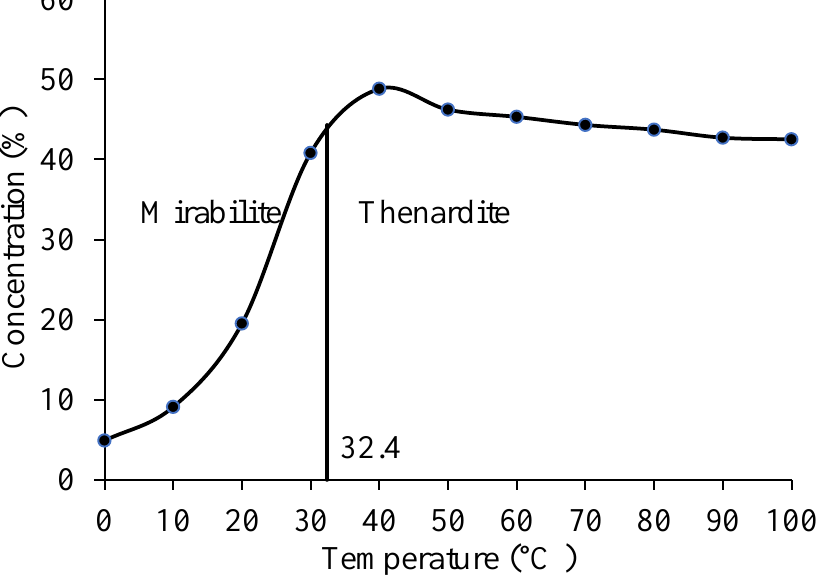
Figure 5. Solubility of thenardite and mirabilite versus temperature (The data digitized from Steiger and Asmussen, 2008) [29].